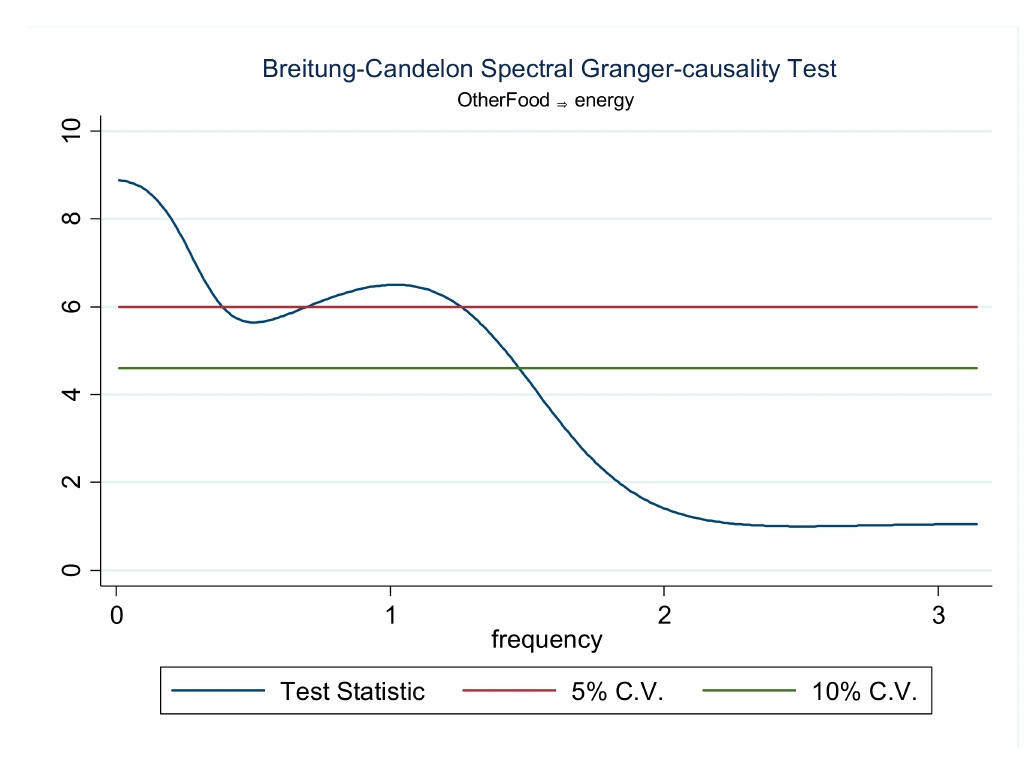
Figure 6. Spectral BC causality from other food to energy.